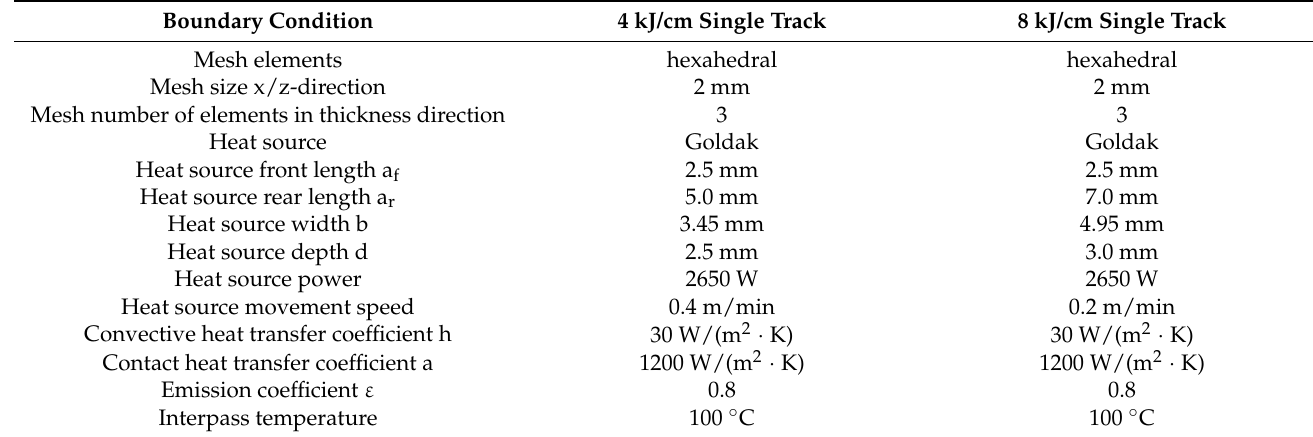
Figure 6. Mesh convergence for mesh sizes 0.5 mm, 1.0 mm and 2 mm. Table 3. Boundary conditions for numerical welding